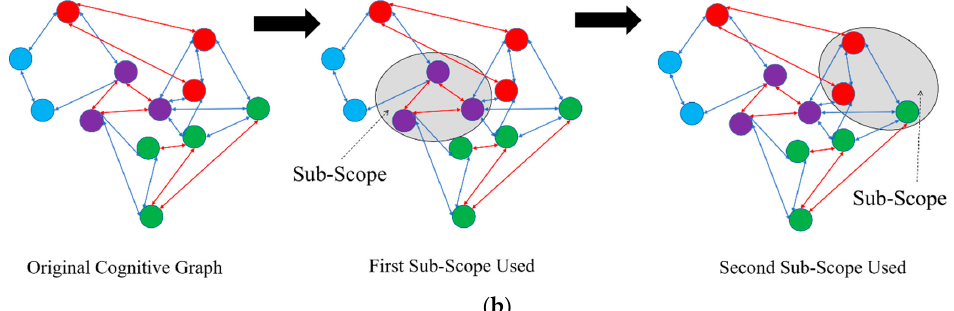
Figure 3. An example of a multi-hop text-based information retrieval task. ( a ). Search request and corresponding information source. ( b ). Reasoning process.